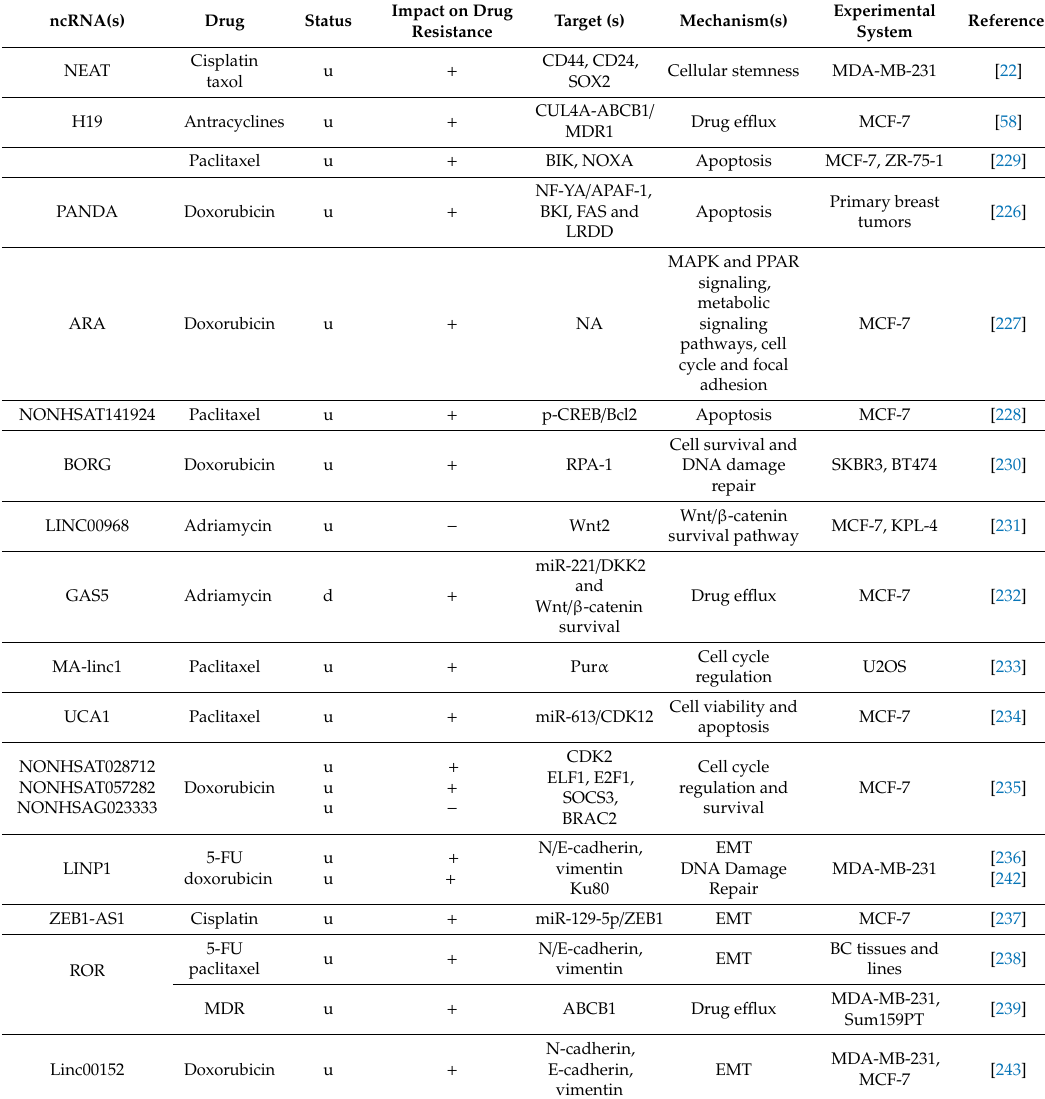
Table 6. Several lncRNAs involved in regulating BC drug resistance to anthracyclines, taxanes, platinum compounds, and antimetabolites 1 ; (u) upregulated; (d) downregulated; ( + ) increase; ( − )